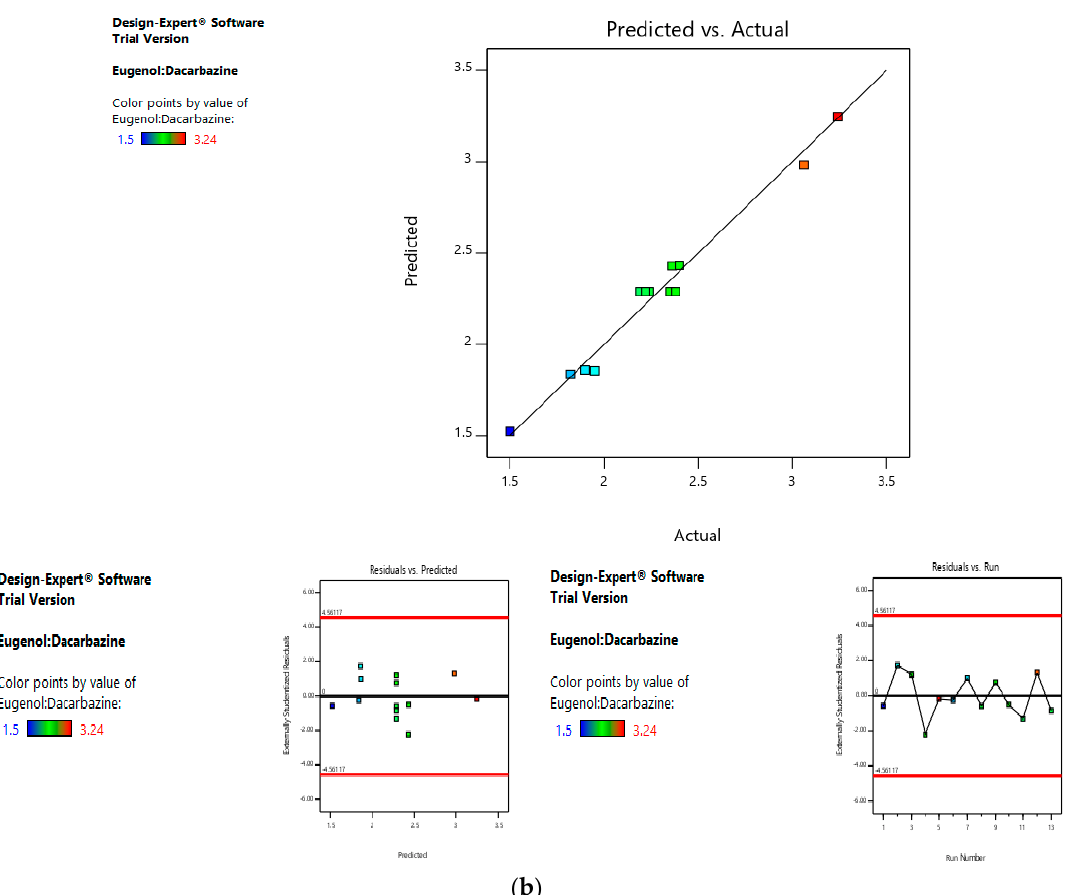
Figure 7. Risk assessment (second level) ( a ) with respect to size. ( b ) with respect to Figure7. Riskassessment(secondlevel)( a )withrespecttosize. ( b Eugenol:Dacarbazine.